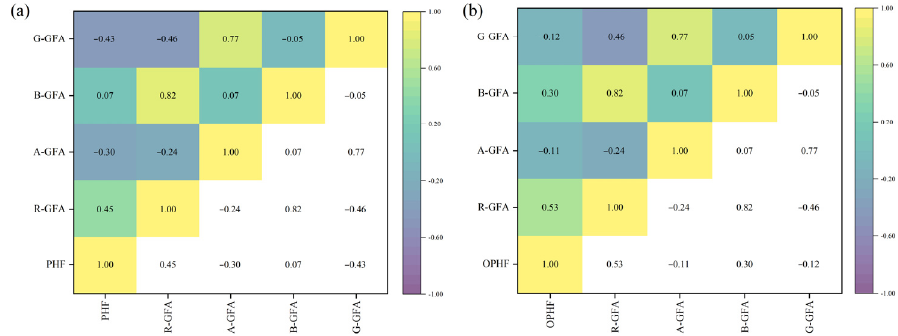
Figure 7. Correlations at residential sites, ( a ) peak periods; ( b ) off-peak periods.